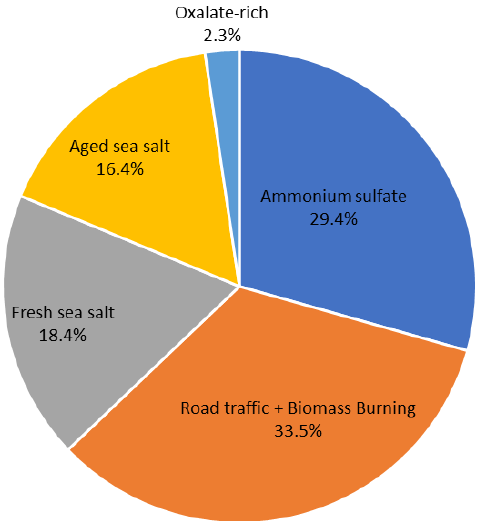
Figure 5. Percentage contribution of the different PMF-resolved factors to the modeled PM 2.5 con- centrations.